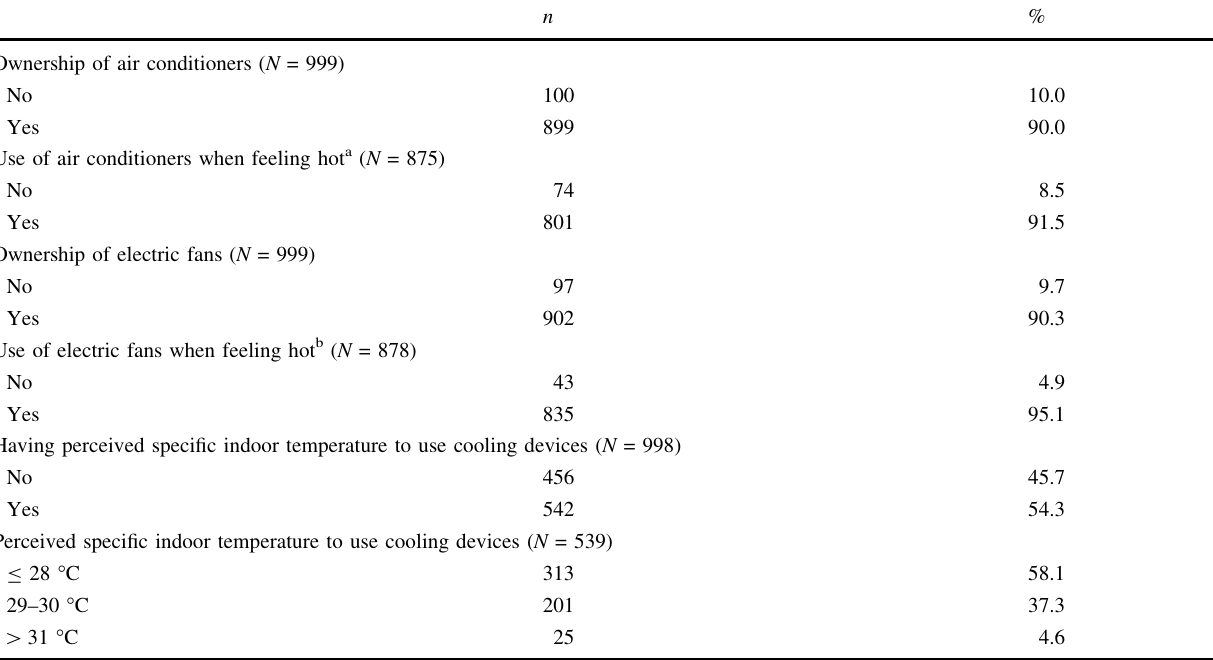
Table 2 Characteristics of ownership and use of cooling devices at home in the risk perception of climate change health impact survey in Hong